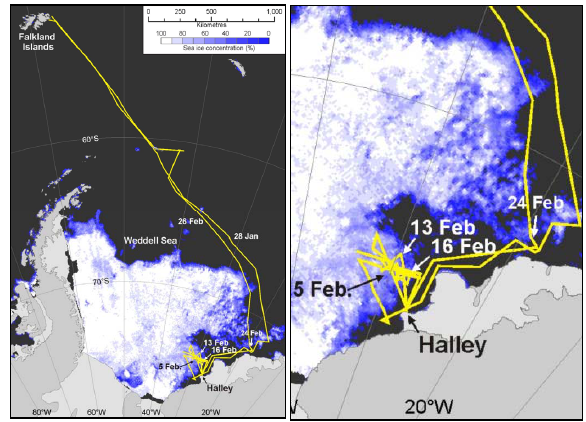
Fig. 1. Cruise path of ES033 in the Southern Ocean and Weddell Sea, and ice cover on 21 February 2011. Ice cores were collected between 5 and 13 February. Between 19 and 22 February the ice shelf experiment was set up close to Halley, where the ship was moored.